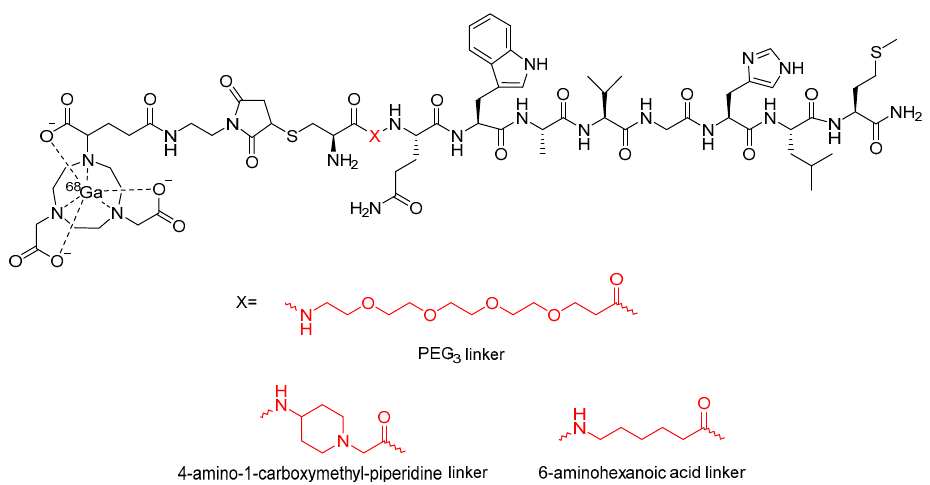
Figure 19. Bombesin-based peptide radiopharmaceutical investigated by the Maecke group, with PEG 4 chain linker and alternative PEG chain lengths highlighted in red [111,112].